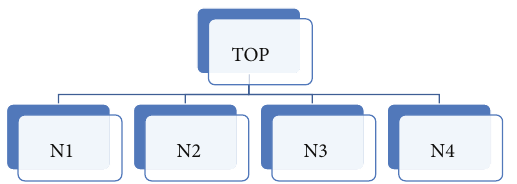
Figure 1: Instance hierarchy for the random waypoint mobility